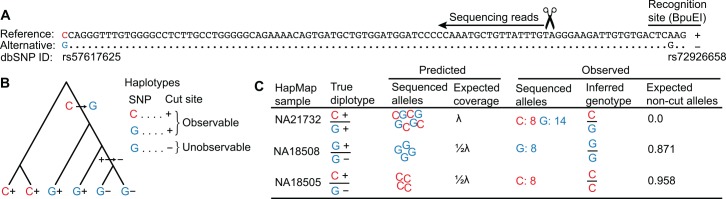
Incorrect inference of genotypes due to restriction site polymorphism.A. GBS reads spanning the SNP rs57617625 originated from a polymorphic BpuEI site 94 bp upstream. The non-cut BpuEI allele caused by SNP rs72926658 is labeled as '−' and the cut allele '+'. B. The '−' allele arose on the haplotype with the derived G allele, causing some G alleles to be unobservable by GBS. C. The samples shown carried the three possible heterozygous diplotypes. The sequencing results were consistent with the predictions. Sample NA18505 was incorrectly called homozygous, but the expected non-cut allele count calculated by GBStools (0.958) closely matched the true count (1), identifying it as a probable mis-call.